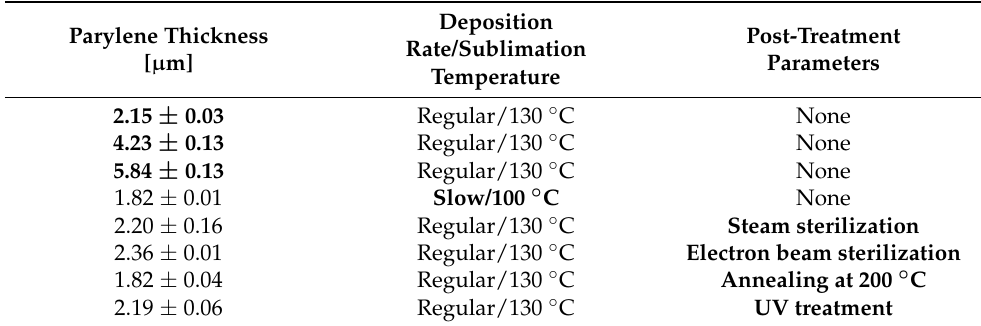
Table 1. Overview of the thicknesses, deposition conditions, and post-treatments of the different Parylene C samples for the investigation of the barrier properties, optical properties, and chemical stability. The varied parameter is highlighted in bold.